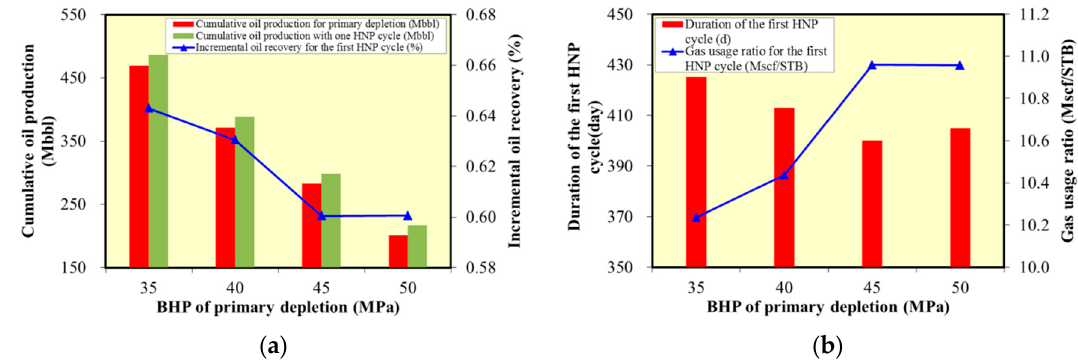
Figure 29. The correlation between BHP of primary depletion and huff-n-puff results: ( a ) Cumulative oil production and incremental oil recovery for different BHP of primary depletion; ( b ) Duration of the first huff-n-puff cycle and gas usage ratio for different BHP of primary depletion.